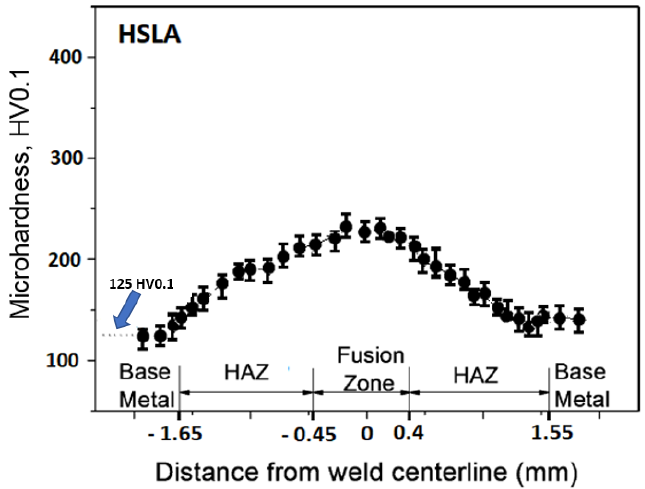
Figure 4. Weld microhardness profiles sample A